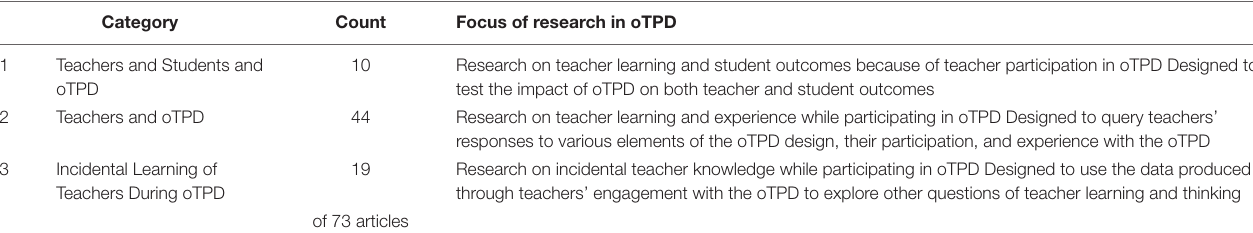
TABLE 2 | Categories in oTPD